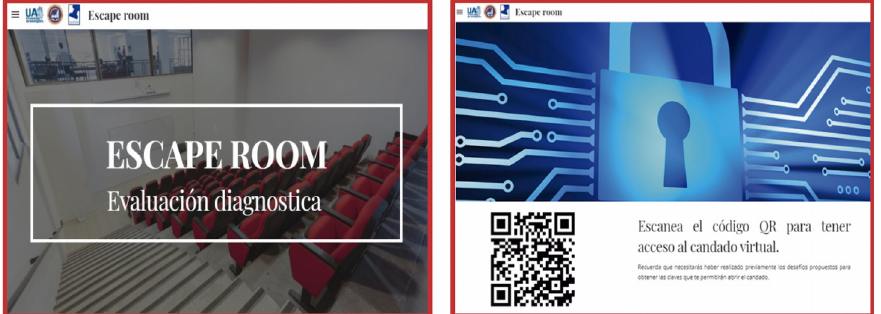
Figure 4. Diagnostic